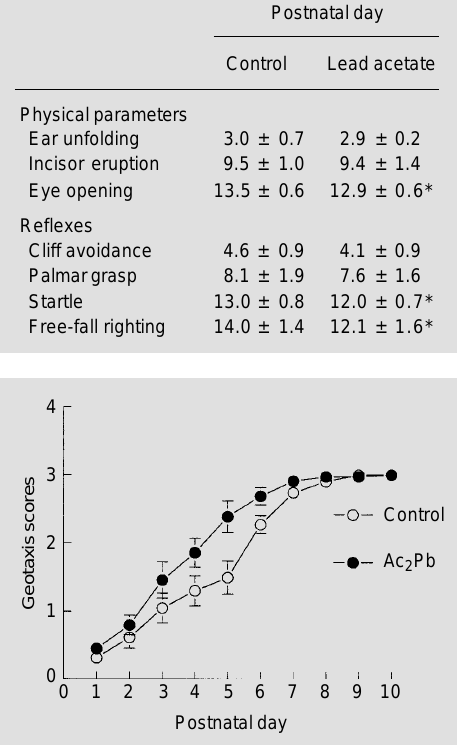
Figure 2 - Effect of lead acetate on the negative geotaxis scores. Data are reported as means ± SEM of 11 control (42 males and 46 females) and 9 Ac 2 Pb litters (38 males and 34 females). F values are presented in